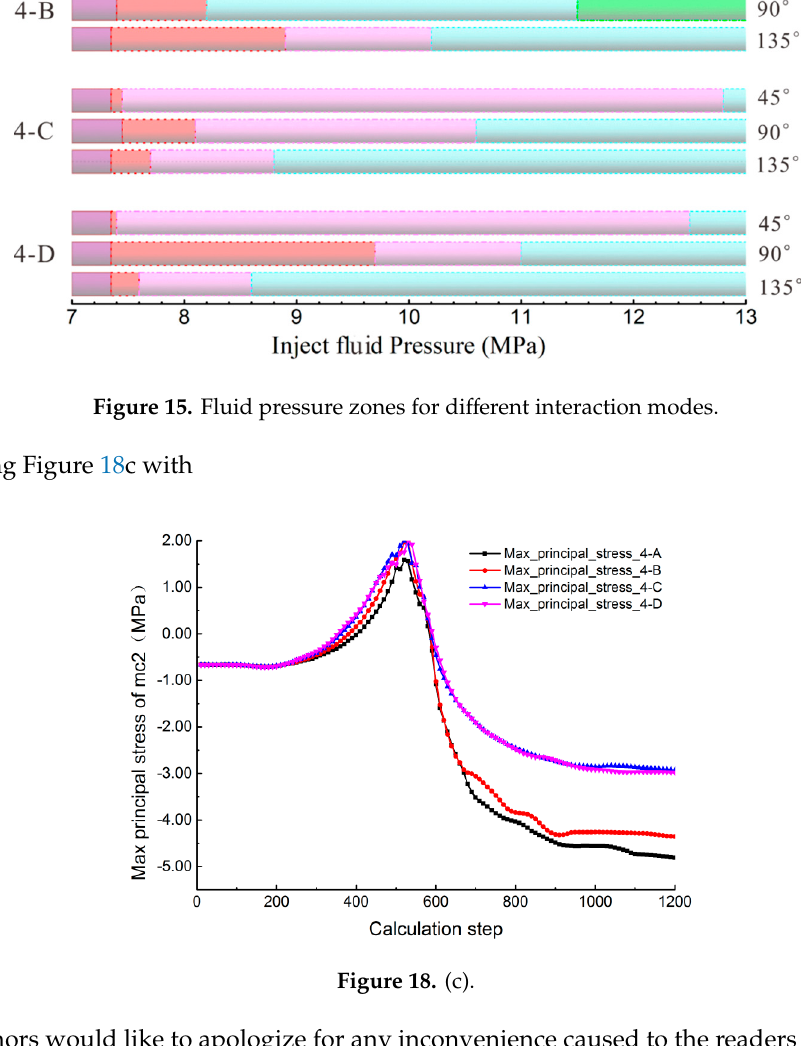
Figure 18. ( c ). Figure 18.